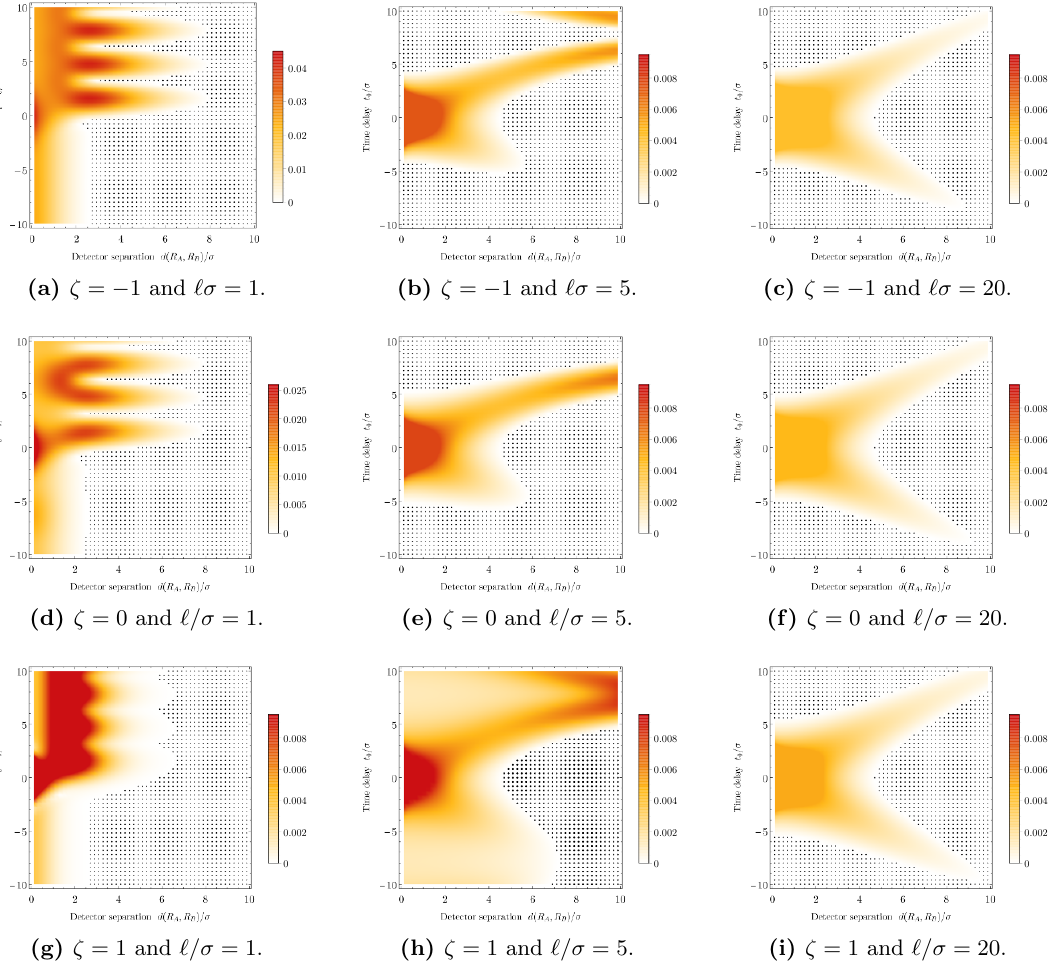
Figure 10 . The concurrence, C = ~ (cid:21) 2 associated with the state (cid:26) AB describing two static detectors is plotted as a function of their proper separation d ( R A ; R B ) =(cid:27) and the relative time delay in their switching functions t 0 =(cid:27) for all boundary conditions (cid:16) = f(cid:0) 1 ; 0 ; 1 g and di(cid:11)erent value of the AdS length ‘=(cid:27) . A negative t 0 means that detector B switches before detector A . Detector A is located